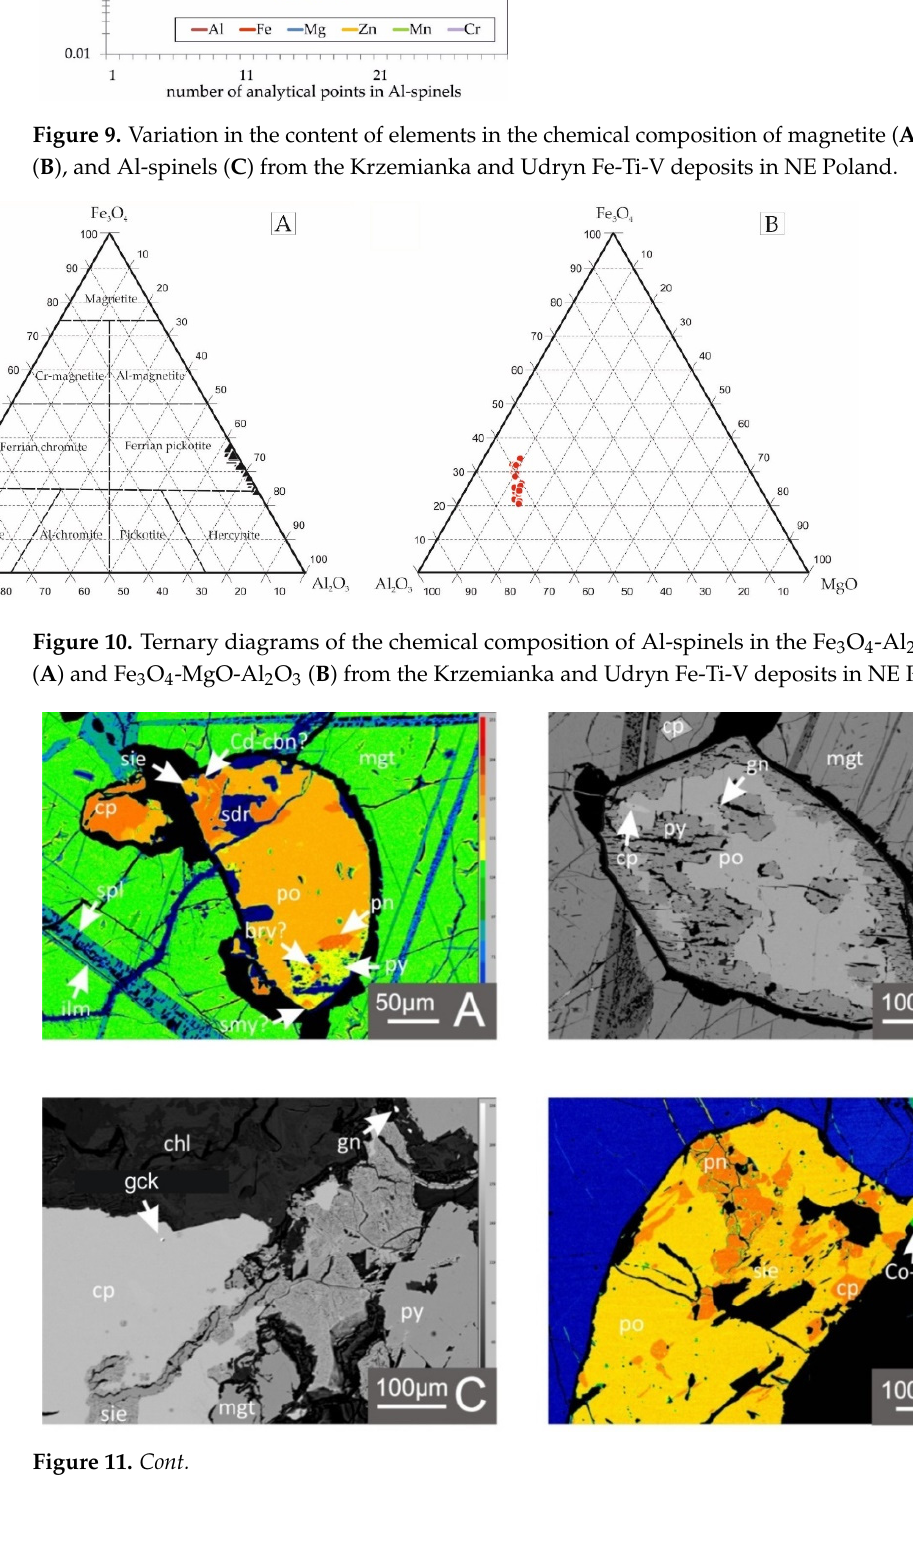
Figure 11. BSE images of characteristic sulphide mineralization hosted by magnetite-ilmenite ores from the Krzemianka and Udryn Fe-Ti-V deposits. ( A ) a typical sulphide aggregate in magnetite